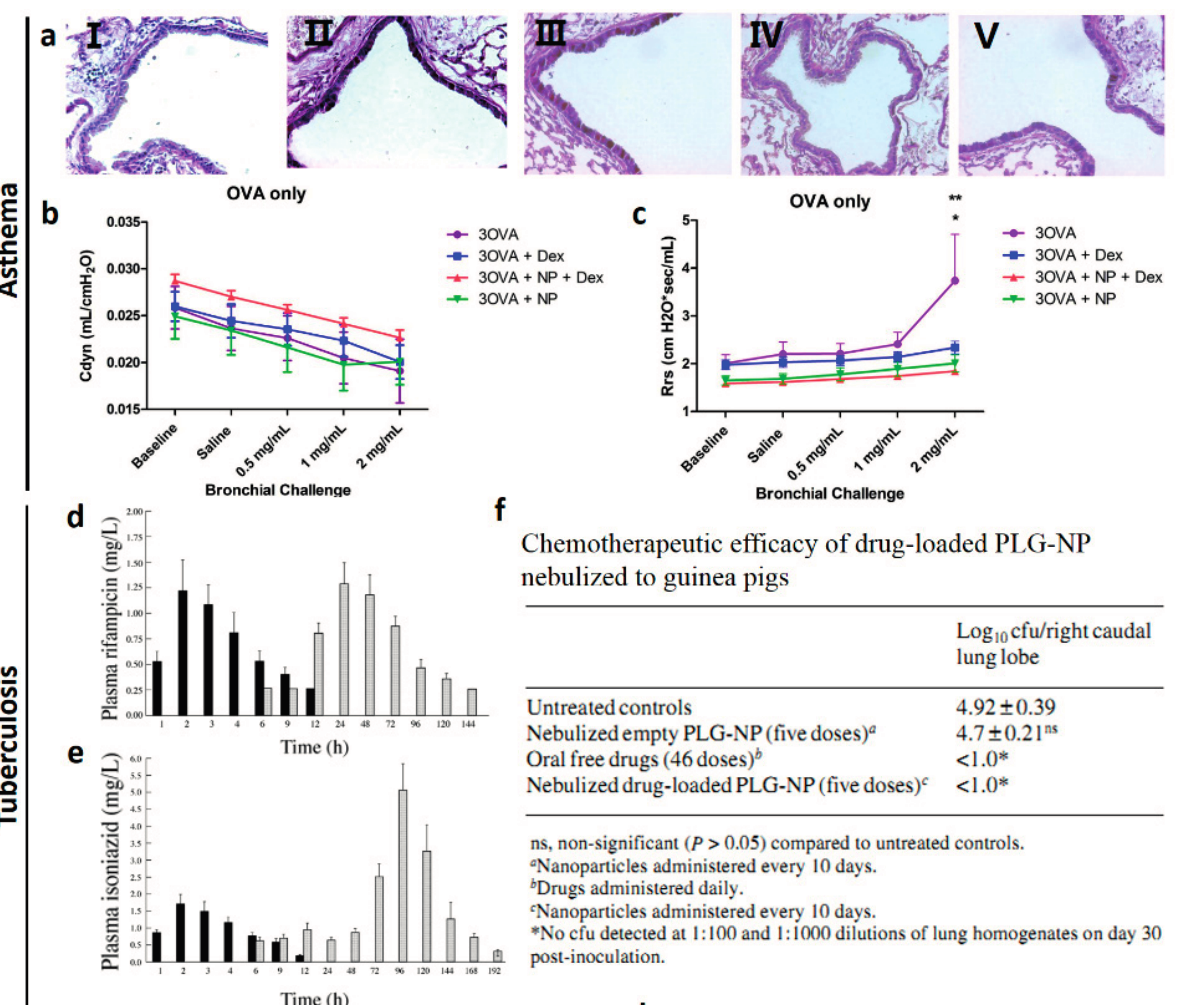
Figure 1. ( a ) Periodic Acid-Schiff staining for goblet cells from representative sections of lobar bronchi or daughter generation airway in mice from air-exposed (I), OVA-exposed (II), OVA-exposed Dex-treated (III), OVA-exposed Dex NP (IV), and OVA-exposed NP (V) treated mice [11]; ( b ) Total lung compliance in mice exposed to either filtered air or 2 weeks of OVA alone [11]; ( c ) Total respiratory system resistance in Balb/c mice exposed to either filtered air or 1 week of OVA alone (treatment with either Dex or itsnanoparticle drug vehicle (NP) independently attenuated Rrs and AHR ( * , ** p < 0.0001) down to air control levels at the highest dose of methacholine) [11]; ( d ) Plasma profile of following the nebulization of drug-loaded PLG-NP, and oral administration of rifampicin [13]; ( e ) Plasma profile of following the nebulization of drug-loaded PLG-NP, and oral administration of isoniazid [13]; ( f ) Chemotherapeutic efficacy of drug-loaded PLG-NP nebulized to guinea pigs [13]; ( g ) Lung section of mouse from the non-treatment group (I), treated with doxorubicin solution intravenously (II), non-effervescent doxorubicin nanoparticle powder (III) and effervescent doxorubicin nanoparticle powder (IV) [14]; ( h ) Percent animal survival versus time